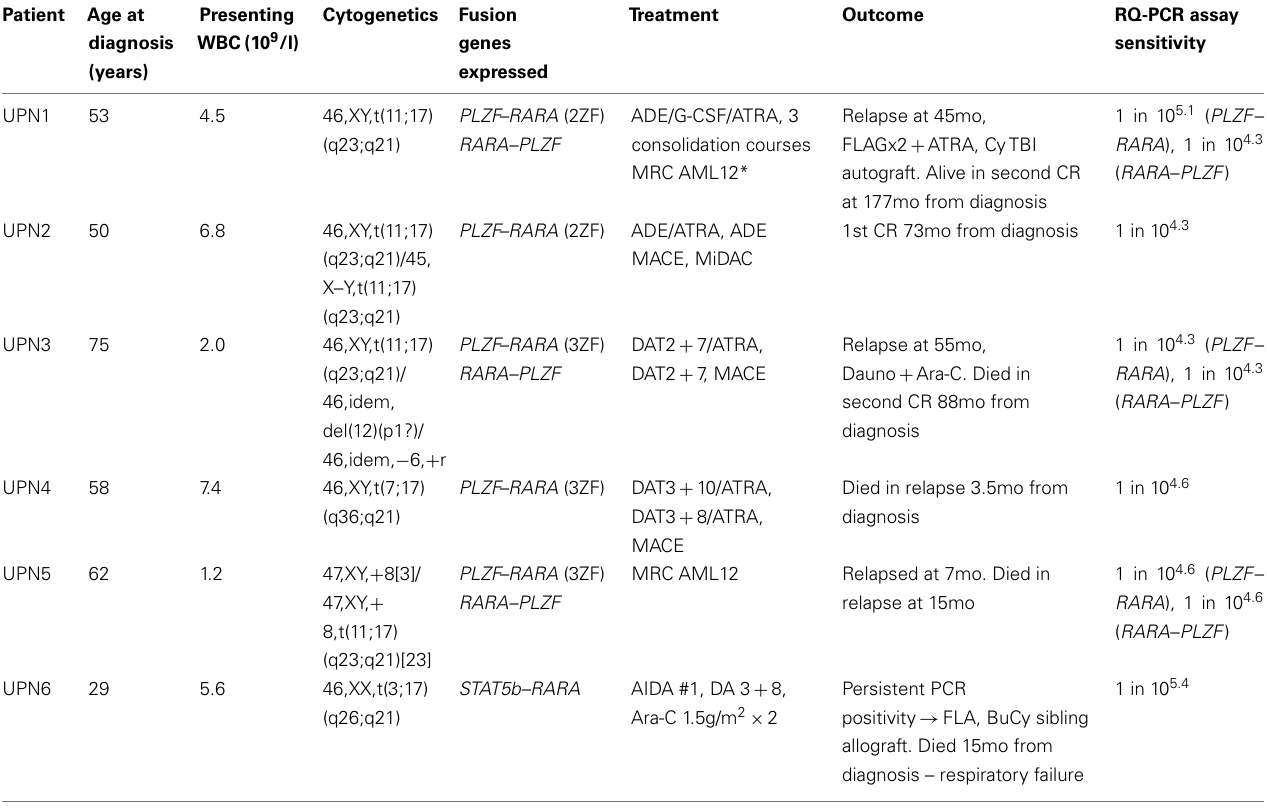
Table 1 | Clinical details and disease characteristics of patients with PLZF–RARA or STAT5b–RARA associatedAPL. Patient Age